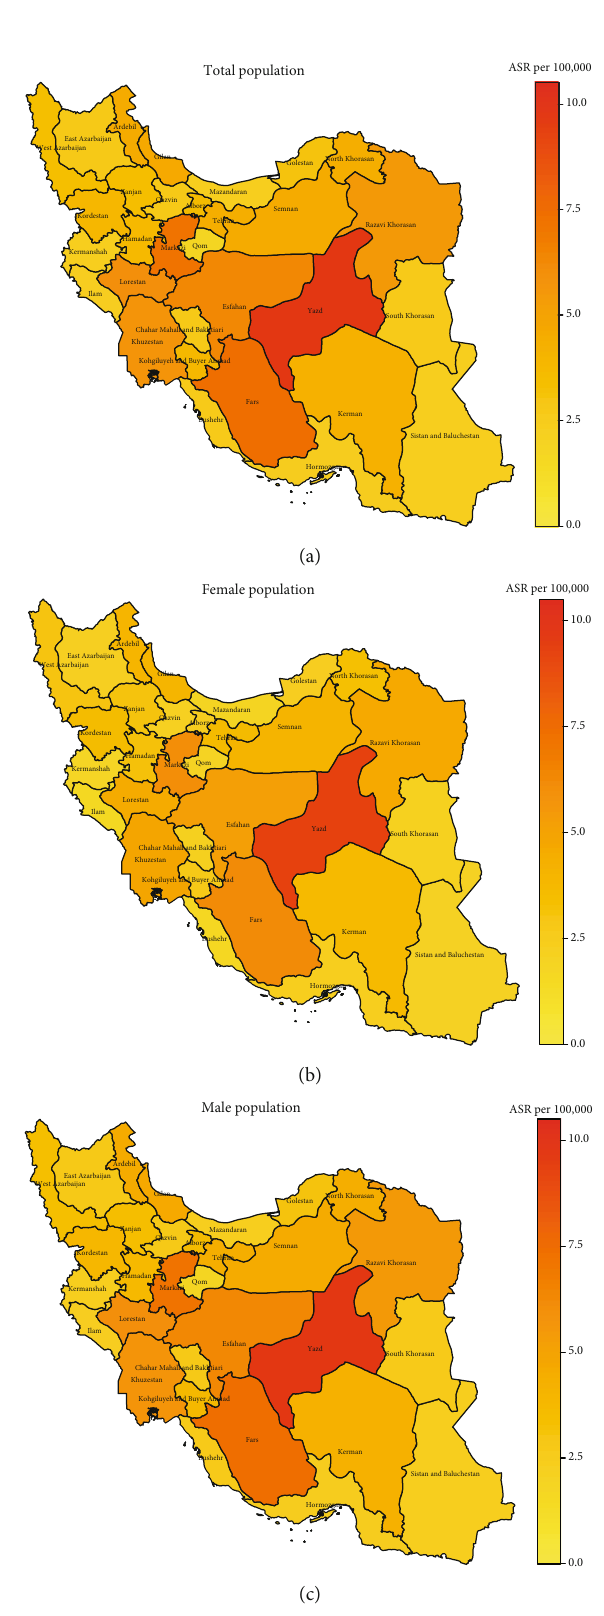
Figure 2: Geographical distribution of CNS tumours by provinces in the total population (a), in the female population (b), and in the male (c)